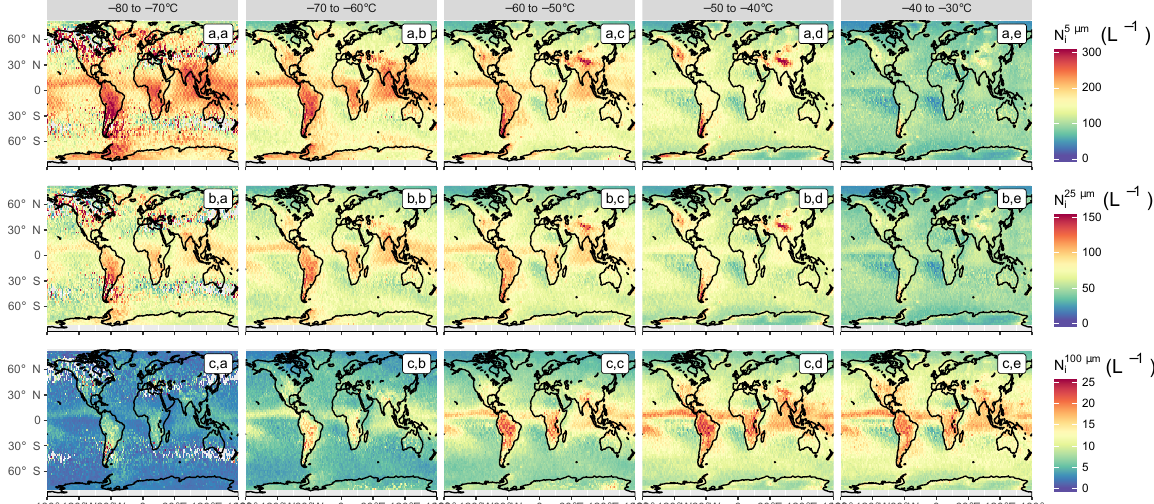
Figure 7. Spatial distribution of N 5µm grid and per 10 ◦ C temperature bin from − 80 to − 30 ◦ C.